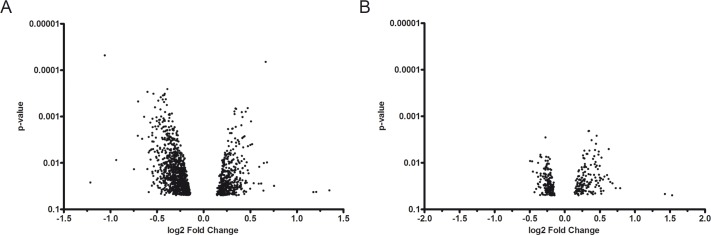
Dot plots of differentially expressed genes associated with QMR treatment at 40 and 80 nominal powers.Images illustrated the distribution of (A) 40 and (B) 80 up- and down-regulated genes (Benjamini & Hochberg correction at p<0.05). The results were assessed by comparing QMR-treated MSC (after one cycle of QMR at 40 and 80 nominal powers) with untreated control cultures. The y-axis was in log10 scale.